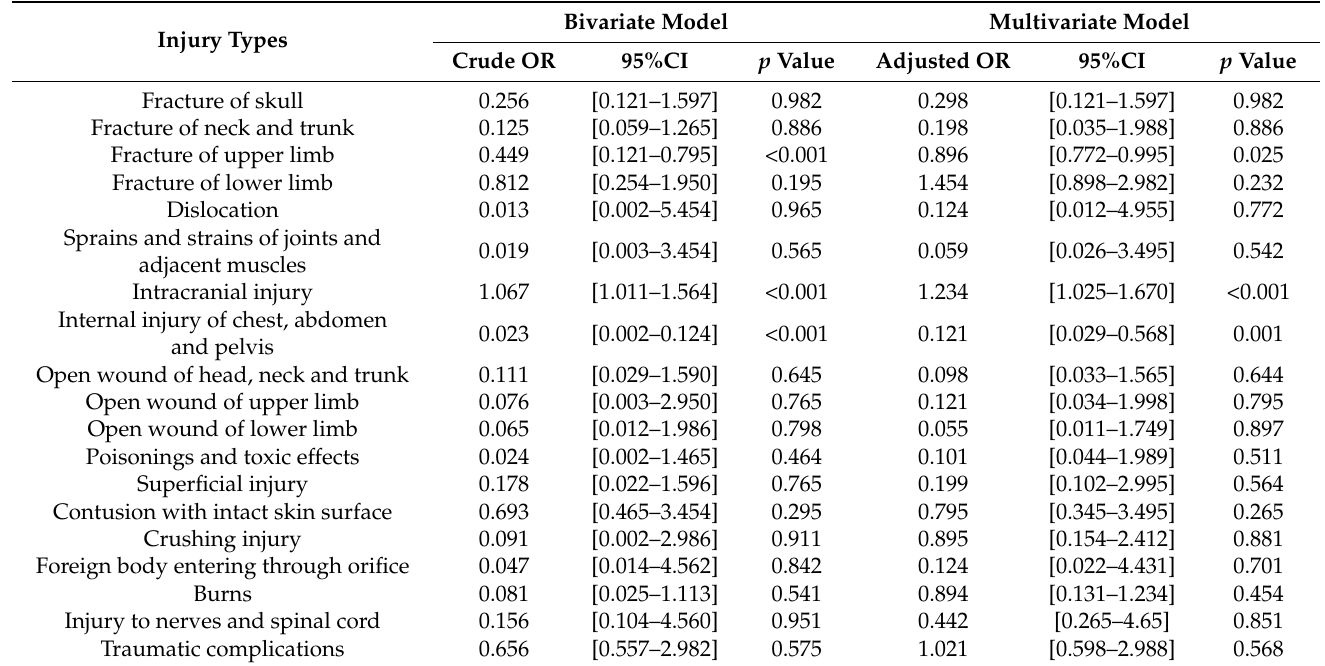
Table 5. Crude and adjusted odd ratios of child abuse for injury types based conditional logistic